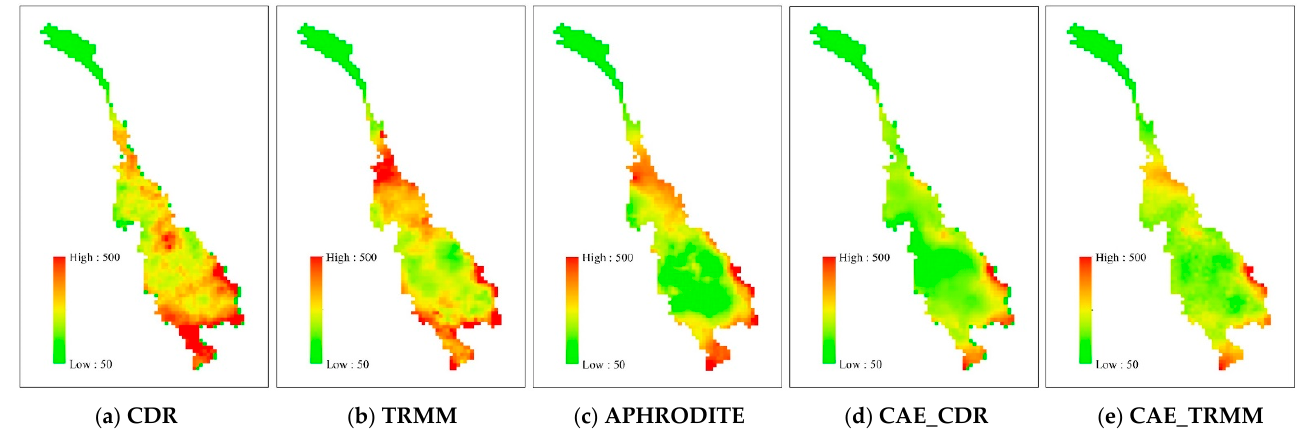
Figure 10. Spatial rainfall distribution of products over the MRB in the dry season of 2015.